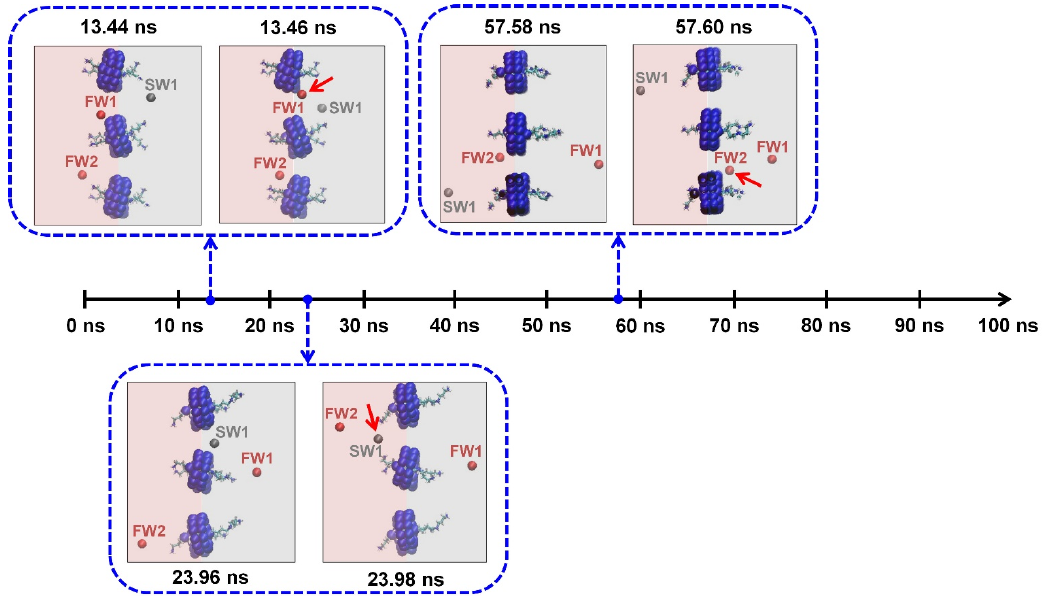
Figure 4. Six frames show water passage across the interstitial space of the 2D CB[6]-spermine nanosheet for 100 ns. The frames represent the three water molecules moving across the interstitial space. The FW1 and FW2 signify two water molecules on the freshwater side, while the SW1 means a water molecule on the saltwater side. The red and grey highlights present the freshwater and saltwater side, respectively. The red arrows indicate the water molecules that moved to the other side. Meanwhile, thioether bridges, dangling arms, NaCl ions, and the other water molecules on the freshwater (red, left) and saltwater (gray, right) sides are not shown for clarity.